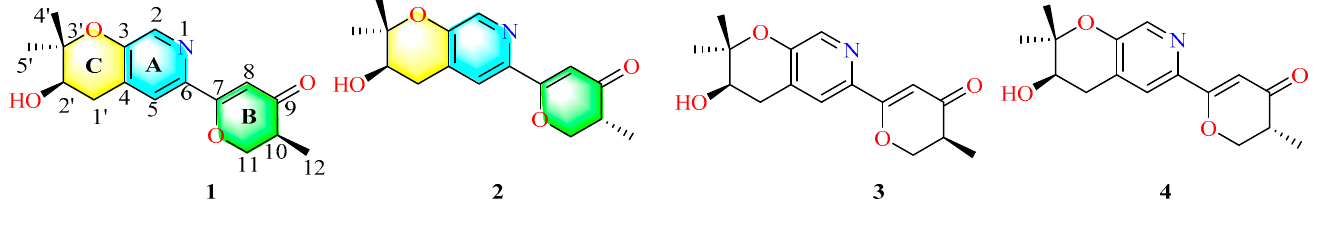
Figure 2. Chemical structures of compounds 1 – 4.